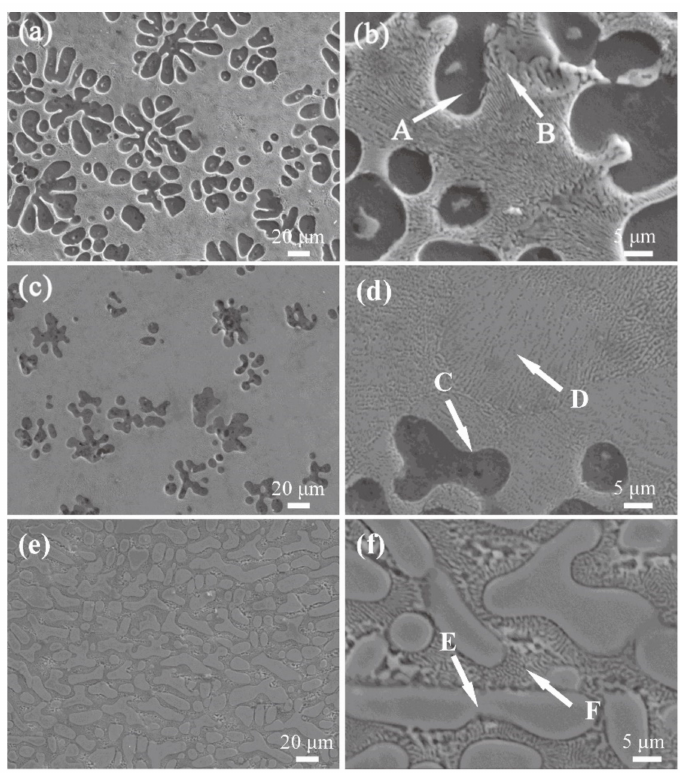
Figure 2. Electron Probe Micro Analysis images of as-cast Mg–Cu alloys: ( a ) Mg-24%Cu, × 400; ( b ) Mg-24%Cu, × 2000; ( c ) Mg-31%Cu, × 400; ( d ) Mg-31%Cu, × 2000; ( e ) Mg-45%Cu, × 400; and ( f ) Mg-45%Cu, ×